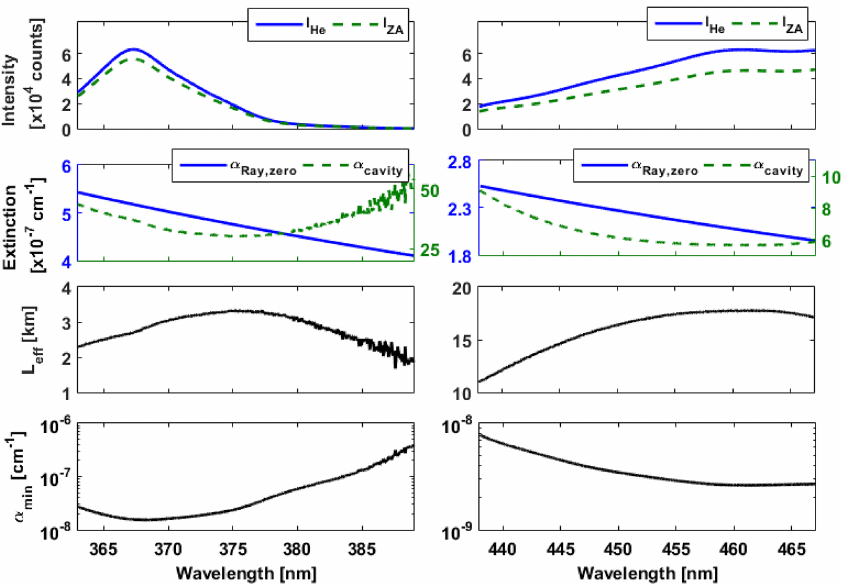
Figure 5. Results from one He / ZA measurement on 5 July 2013 with 0.5s exposure time for Ch 368 (left panels) and Ch 455 (right panels). Figures show light intensity for He ( I He ) and zero air ( I ZA ) measurements for raw counts at the CCD detector (incident photon counts are 16 × greater due to detector gain), calculated extinction due to the Rayleigh scattering of zero air ( α Rayleigh , ZA (λ)) , light attenuation due to cavity loss ( α Cavity (λ) = ( 1 − R(λ))/d) , effective path length ( L eff ) at each pressure (918.5hPa and 918.7hPa for Ch 368 and Ch 455, respectively), and calculated detection limit ( α min ) . The calculated α min represent the theoretical 1 σ shot noise limit for a 0.5s exposure and do not include the factor of 16 gain setting. Theoretical α min for a 5s integration are a factor of 12.6 (16 1 / 2 × 10 1 / 2 ) lower than shown (i.e., 1.2 × 10 − 9 cm − 1 at 368nm in the left panel and 2.4 × 10 − 10 cm − 1 at 460nm in the right